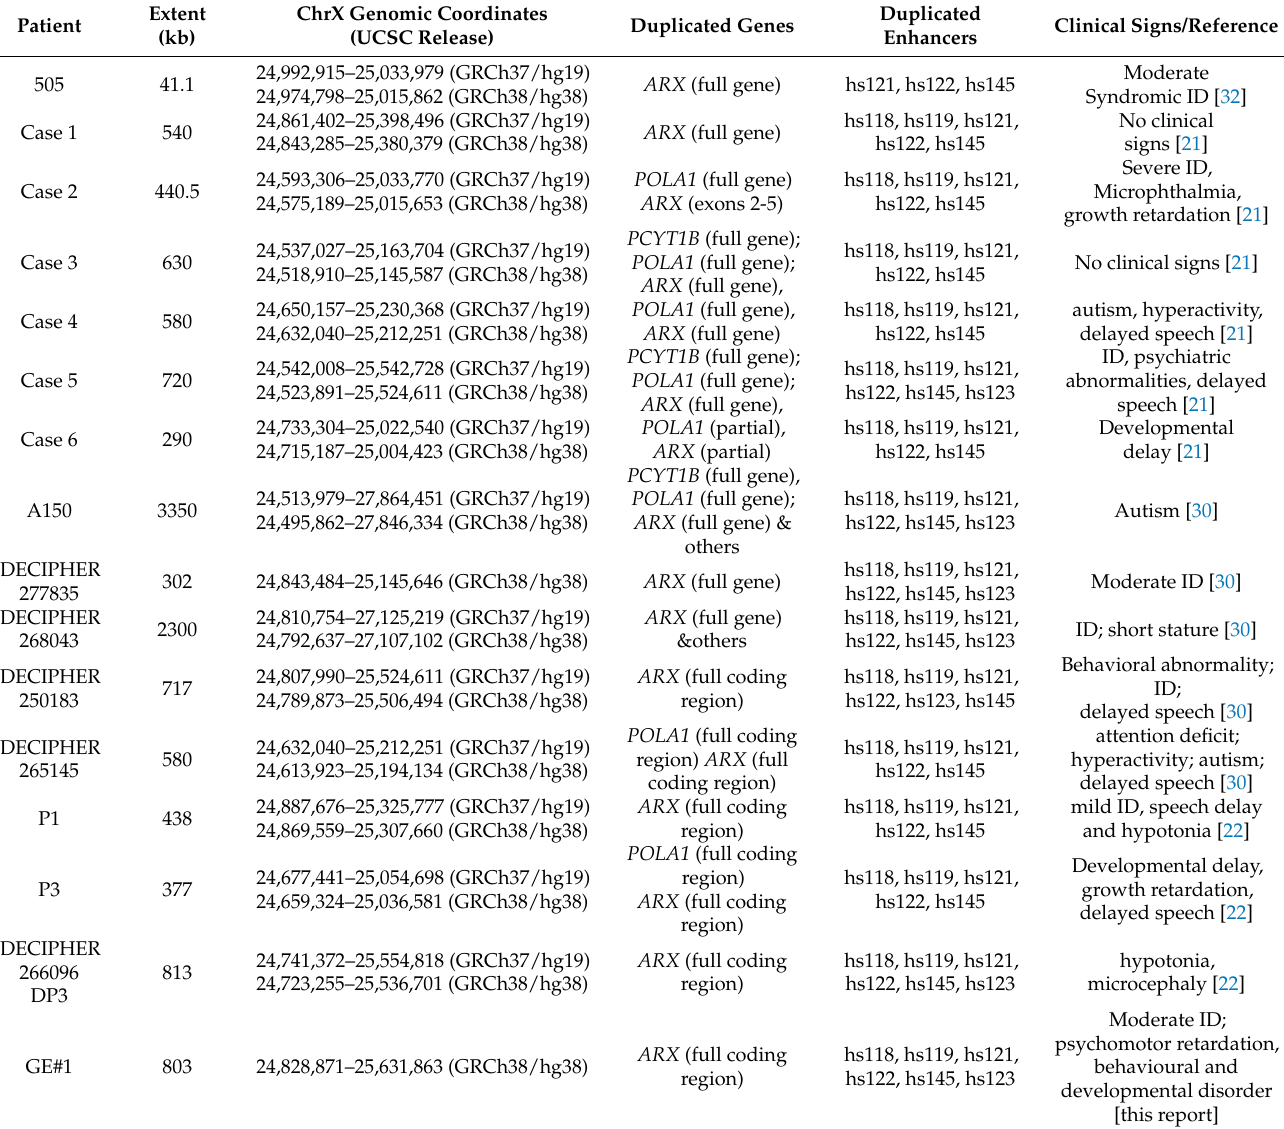
Table 1. ARX duplications and clinical